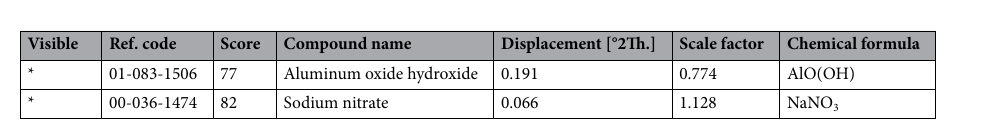
Table 1. Identified patterns list from XRD results of Cu(II)-MP-bis(AMP)@boehmite catalyst.